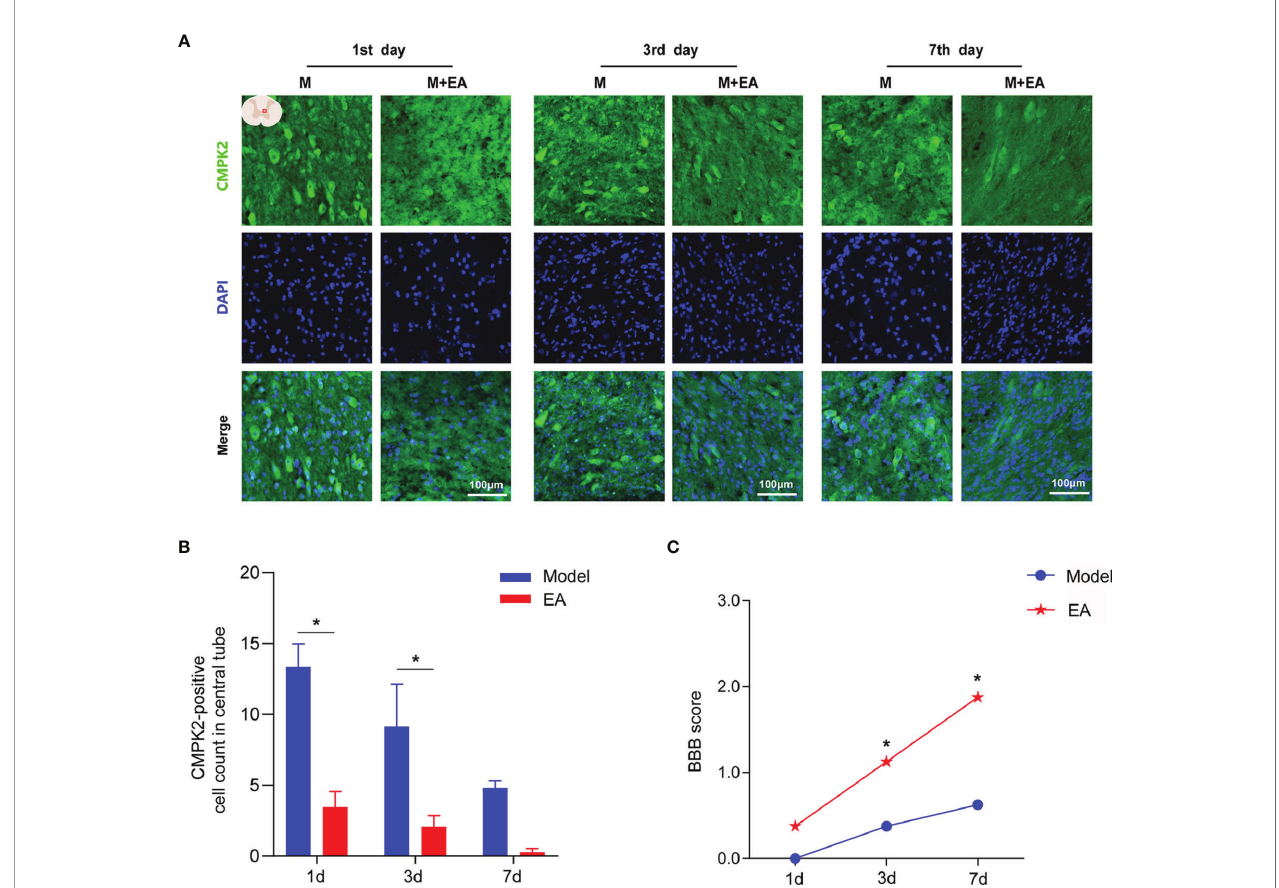
FIGURE 4 | Immuno fl uorescence analysis showed positive expression of CMPK2 in spinal cord tissues of the model and EA groups. (A) Immuno fl uorescence labeling represented the number of CMPK2-positive cells (green fl uorescence) at 1, 3, and 7 days after SCI, and the CMPK2-positive protein staining area is shown in green. (B) Quantitative analysis of CMPK2-positive cells. *p < 0.05 compared with the model group; one-way anOVA was used for comparison. N = 5 rats/group. (C) BBB scores for the model and EA groups. N = 8 rats/group. * p < 0.05 compared with the sham group. Data are presented as the mean ± SEM. EA, electroacupuncture; BBB, Basso – Beattie –